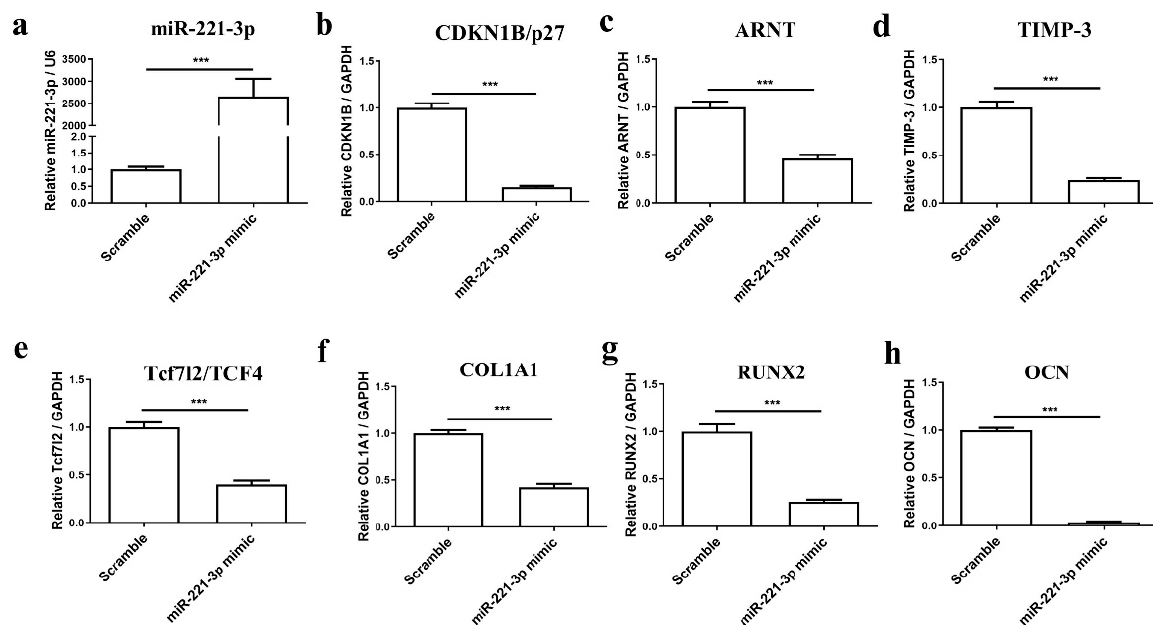
Figure 3. MiR-221-3p can act in osteoblasts. Osteoblasts were transfected with miR-scrambled or miR-221-3p mimic for 2 weeks in ODM, the expression level of miR-221-3p ( a ), the expression of putative targets of miR-221-3p, CDKN1B/p27 ( b ), ARNT ( c ), TIMP-3 ( d ), and Tcf7l2/TCF4 ( e ) and osteogenic markers COL1A1 ( f ), RUNX2 ( g ), OCN ( h ) were measured by RT-qPCR. CDKN1B/p27, ARNT, TIMP-3, Tcf7l2/TCF4, COL1A1, RUNX2, OCN relative to GAPDH, and miR-221-3p relative U6. *** p < 0.001 vs. corresponding control.